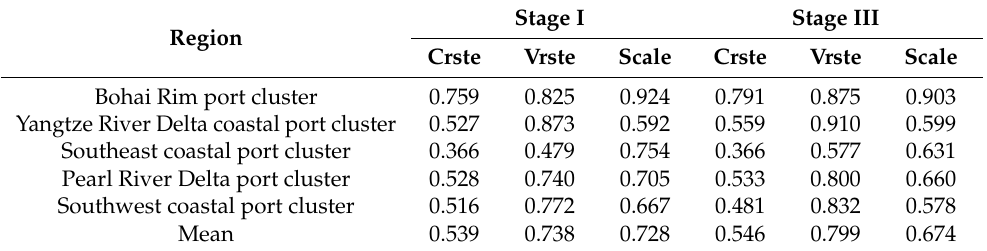
Table 6. The average value of port logistics efficiency by region (2014-2018).